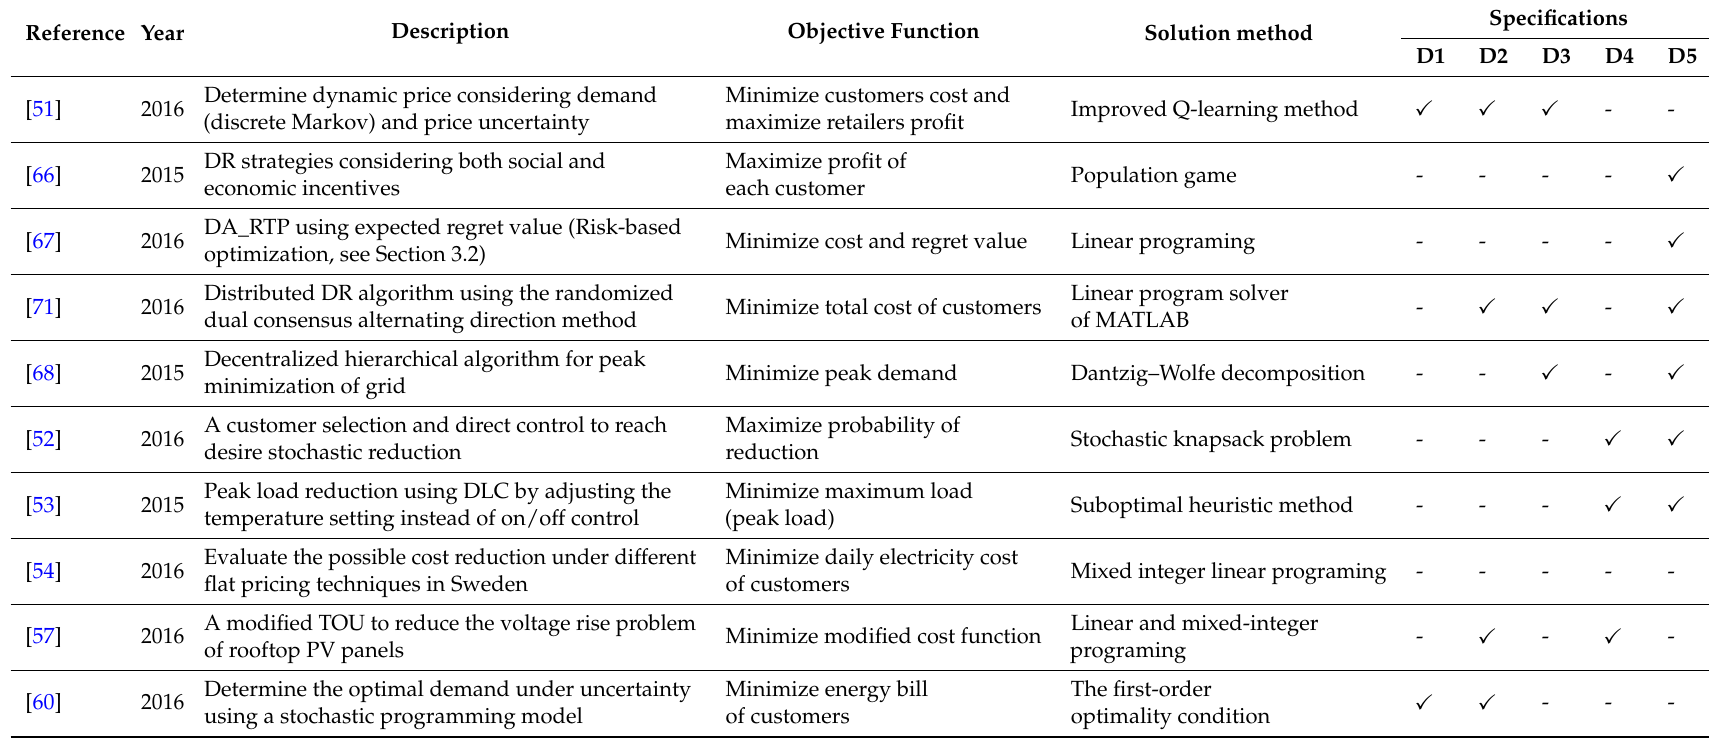
Decentralized hierarchical algorithm for peak A customer selection and direct control to reach desire stochastic reduction Peak load reduction using DLC by adjusting the temperature setting instead of on/off control Evaluate the possible cost reduction under Evaluate the possible cost reduction under different flat pricing techniques in Sweden different flat pricing techniques in Sweden